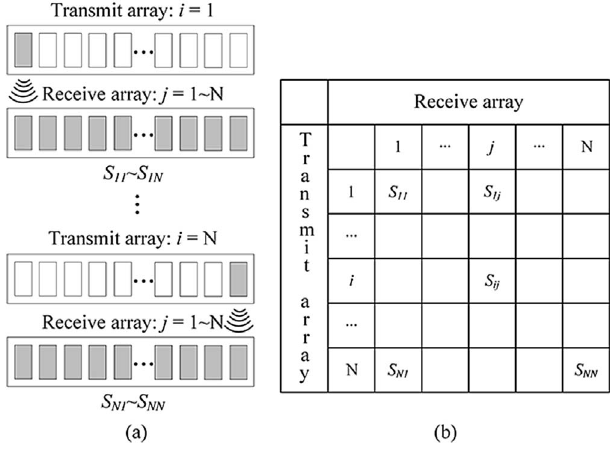
Figure 2. (a) The principle of FMC. Every element is excited sequentially, while all elements receiving A-scan signals of the echo data. (b) The full matrix data { S ij } of N (cid:1) N